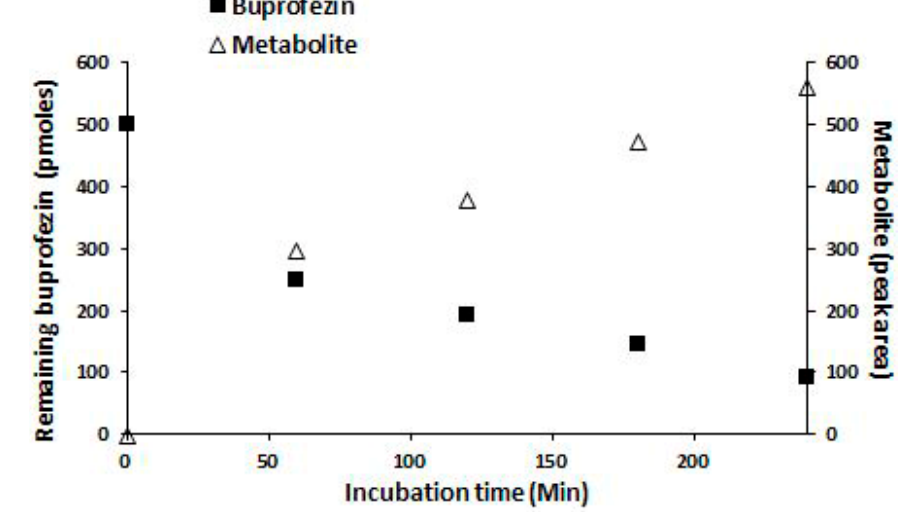
Figure 4. Time course of buprofezin depletion (squares) and metabolite formation (triangles). Approximately 60% of buprofezin was metabolized within 4 h. Reactions were performed at 30 °C with 100 µM buprofezin.